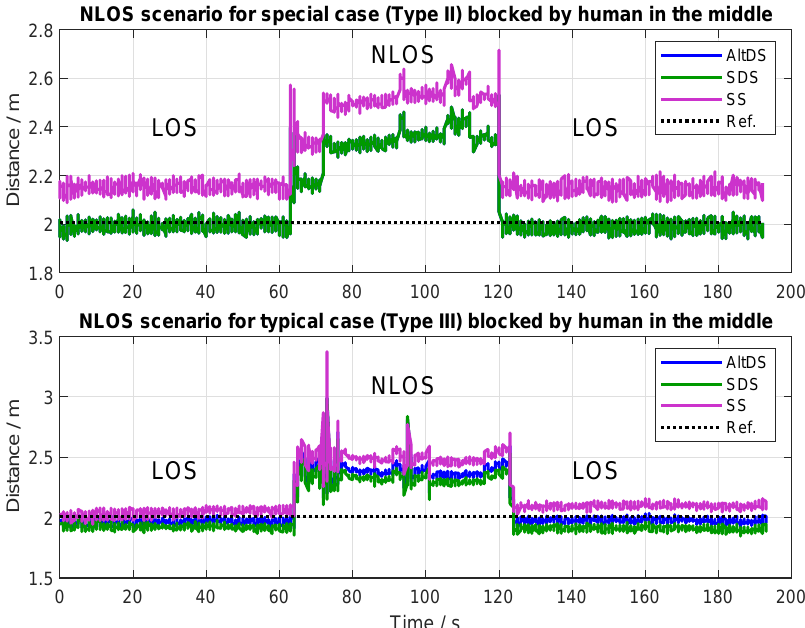
Figure 14. NLOS scenarios for Types II and III at 2 m when a human subject is